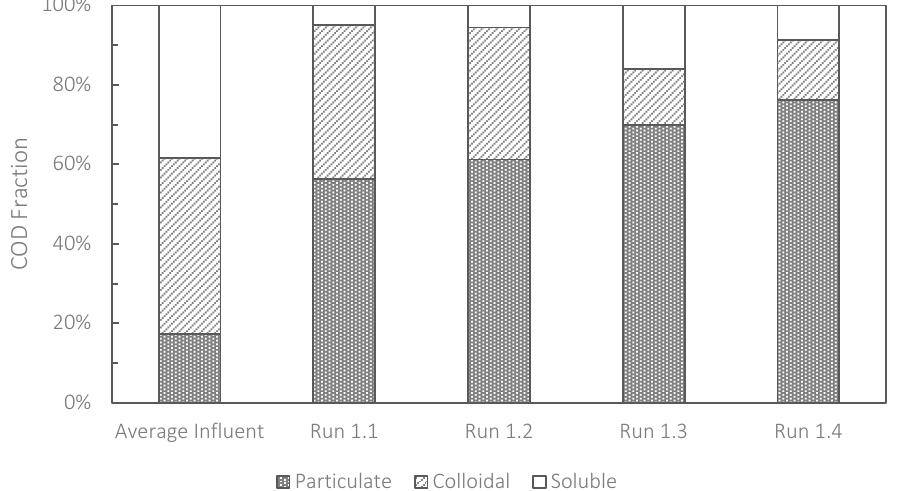
Figure 4. Size distributions (particulate, colloidal and soluble) of COD in the biomass suspension just before termination of Runs 1.1 to 1.4.